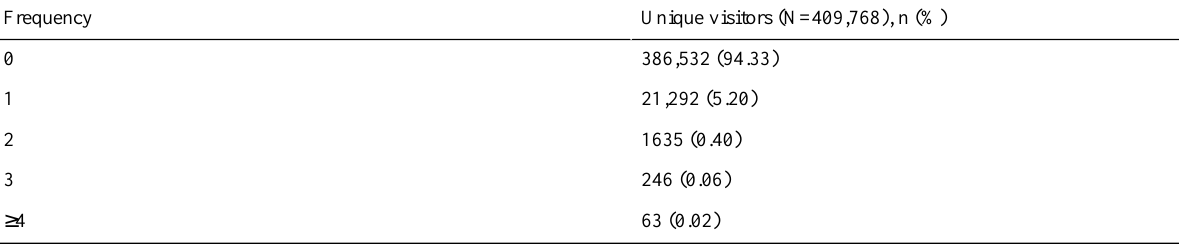
Table 4. Frequency of clinic menu requested from unique interactions.